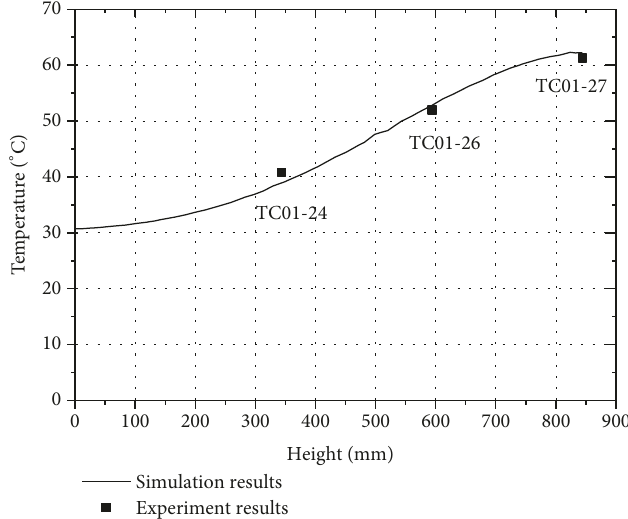
Figure 29: The temperature contrast of simulation and experiment at the support front plate in Test FS1.